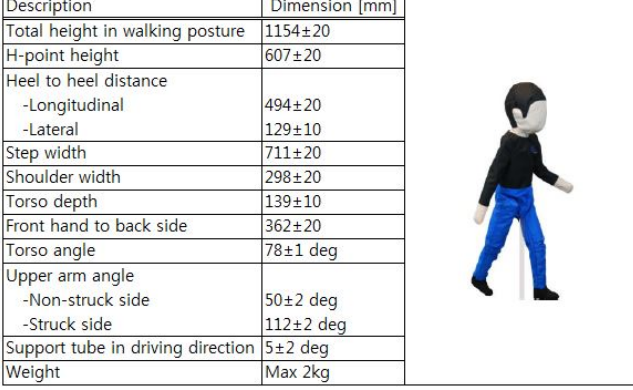
Figure 9. Euro NCAP child pedestrian target.